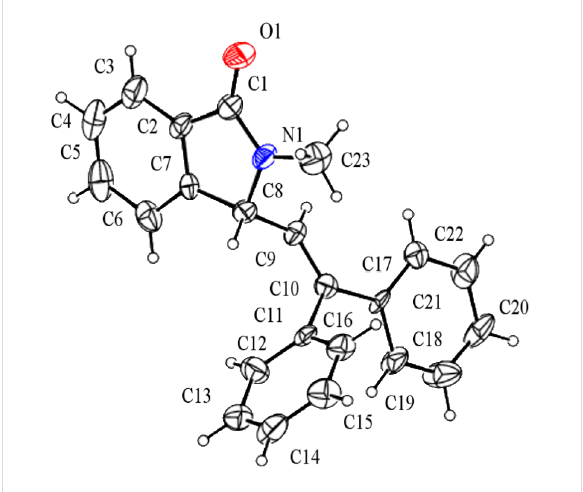
Figure 1: X-Ray structure (ORTEP drawing) of 3h